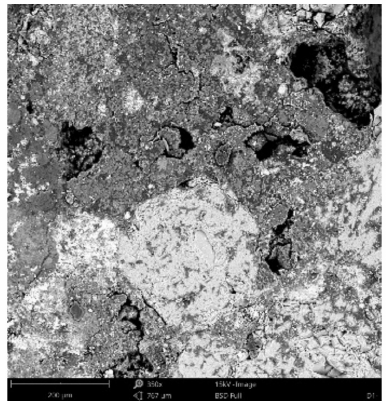
Figure 21. Phenom XL Desktop SEM photos.